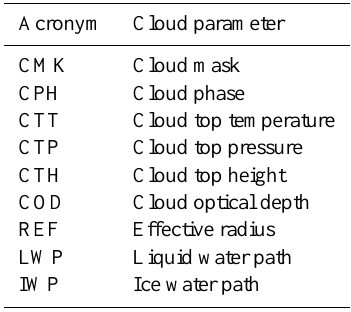
Table 3. Participating